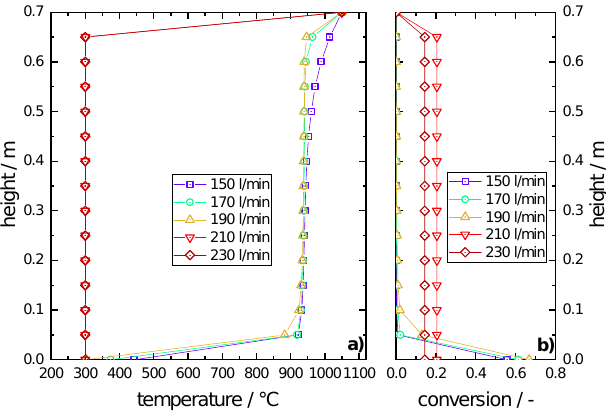
Figure 6b. For gas flow rates above the tipping point, the kinetic limitation of the material leads to a reduced conversion as a consequence of increased cooling rates. Furthermore, the particles oxidize shortly after the particle inlet; i.e., in less than 5 cm. The oxidation of the particles can only take place within the range of the topmost 5 cm below the particle inlet.